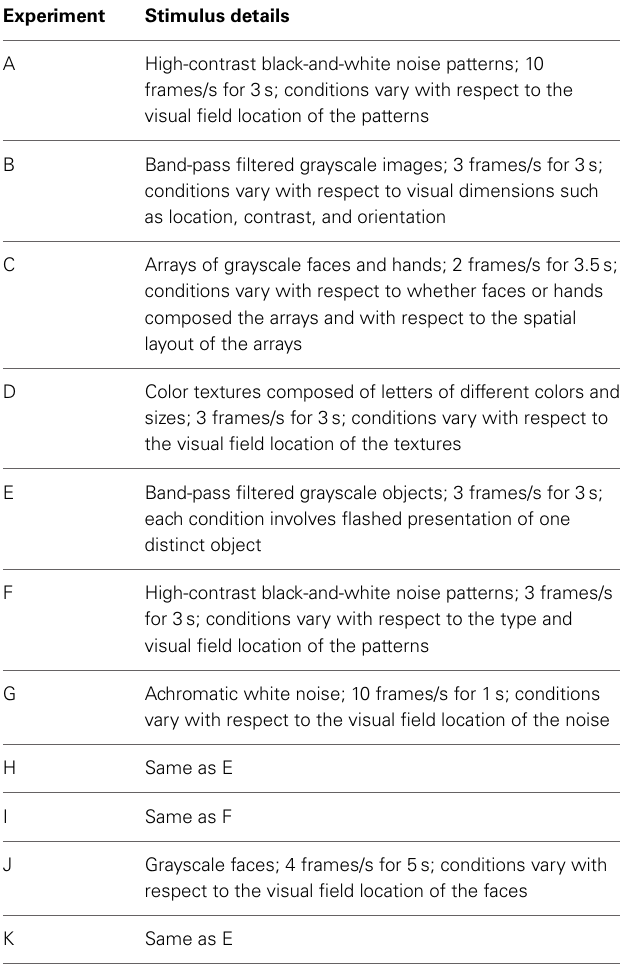
Table 2 | Details of the stimuli used in the experiments. Experiment